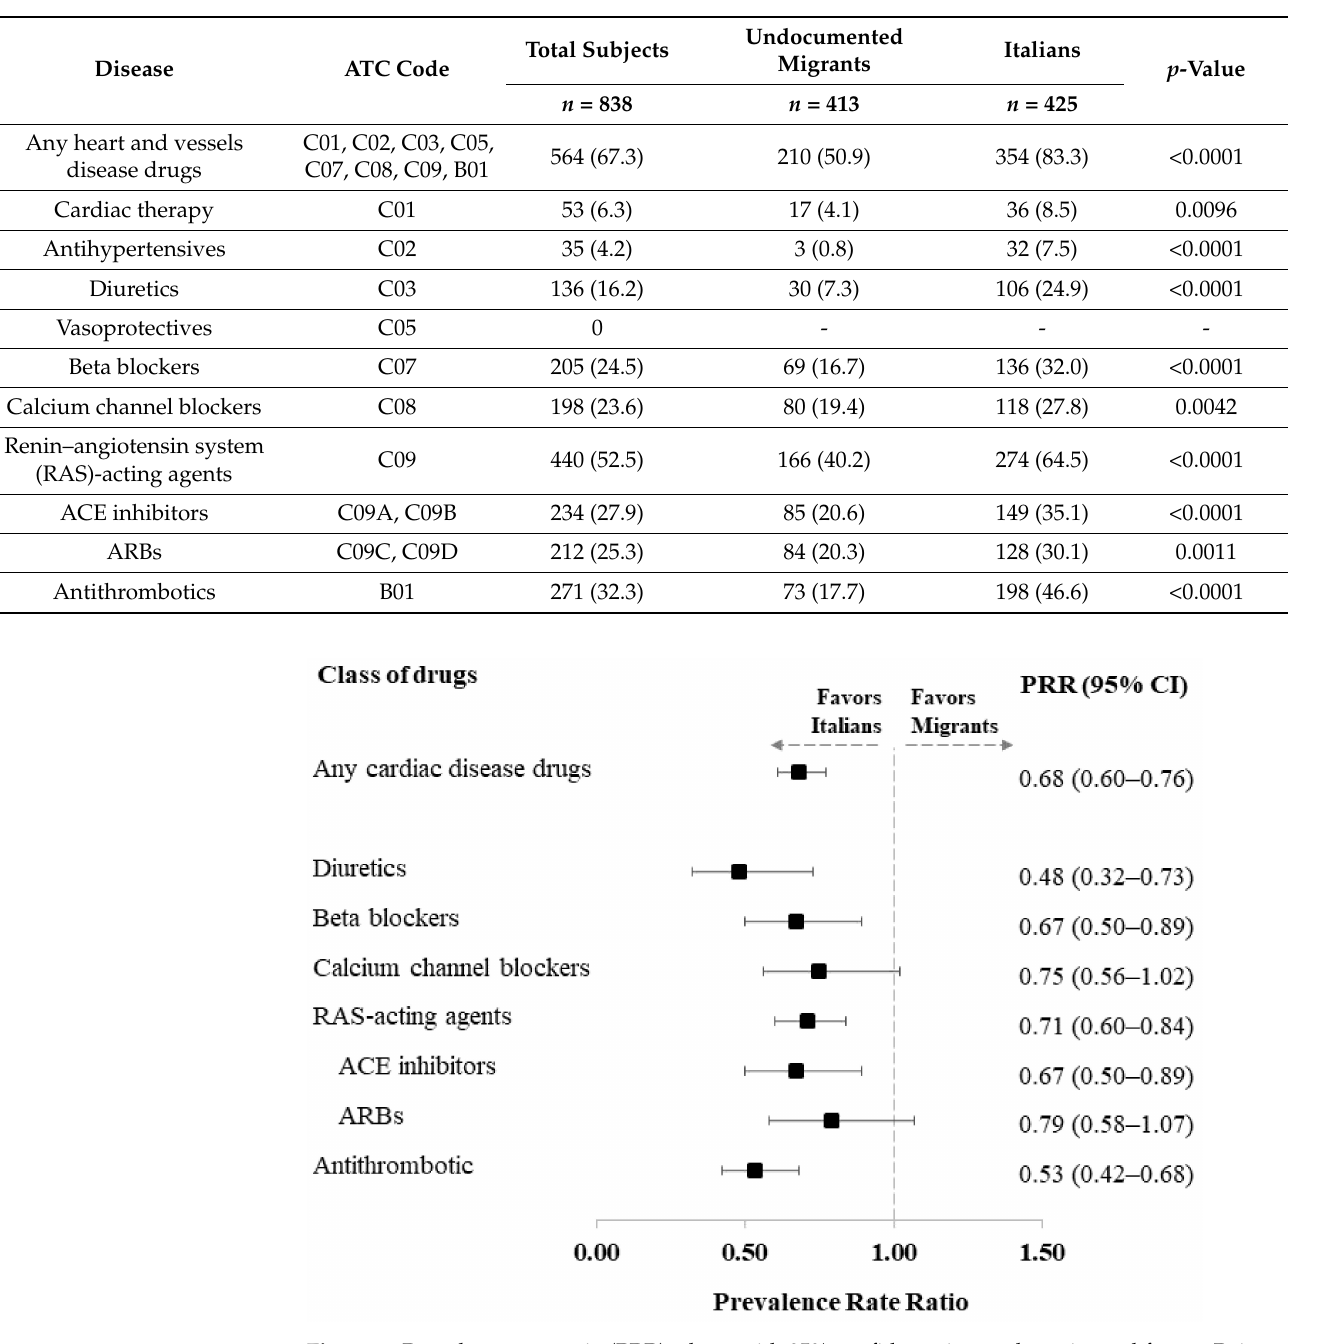
Figure 2. Prevalence rate ratio (PRR), along with 95% confidence intervals, estimated from a Poisson regression model for comparing the prevalence of use of selected cardiovascular therapy drugs between undocumented migrants and Italians, adjusted for patients’ characteristics (age class, sex, comorbidities, and